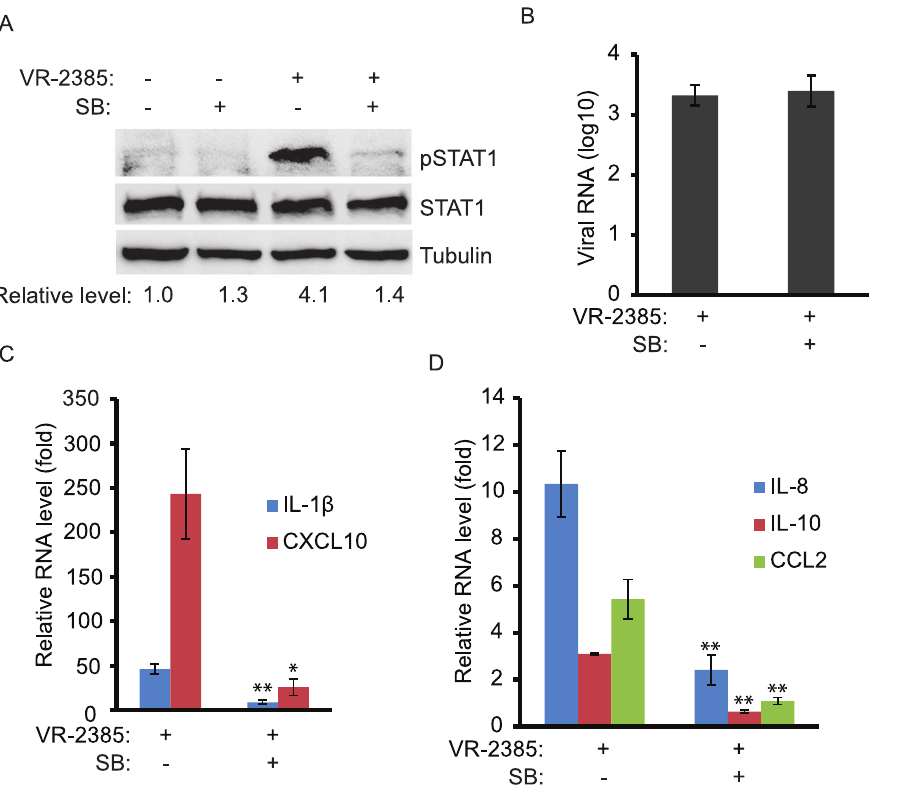
Figure 6. PRRSV infection of PAM cells leads to elevation of pSTAT1-S727. A. Elevation of pSTAT1-S727 in VR-2385-infected PAM cells detected by Western blotting. The cells were infected with VR-2385 and treated with SB203580. Mock-infected and mock-treated cells were included as controls. The blotting was done with antibodies against pSTAT1-S727, STAT1 and tubulin. Relative levels of pSTAT1-S727 compared to the mock- treated control are shown as folds below the images. B. PRRSV viral RNA copies in PAMs detected by RT-qPCR and shown as log10 per 10 ng total RNA. C&D. Increased expression of IL-1 b , CXCL10, IL-8, IL-10, and CCL2 in PRRSV-infected PAMs detected by RT-qPCR. The cells were infected with VR-2385 and treated with SB203580. Relative levels of gene expression are shown as folds in comparison with the mock-treated PRRSV-negative